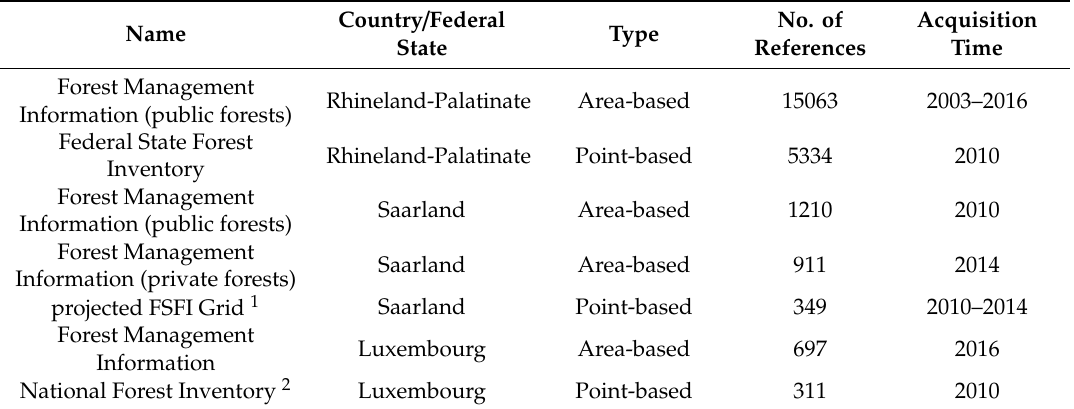
Table 2. Overview and characteristics of the available forest information